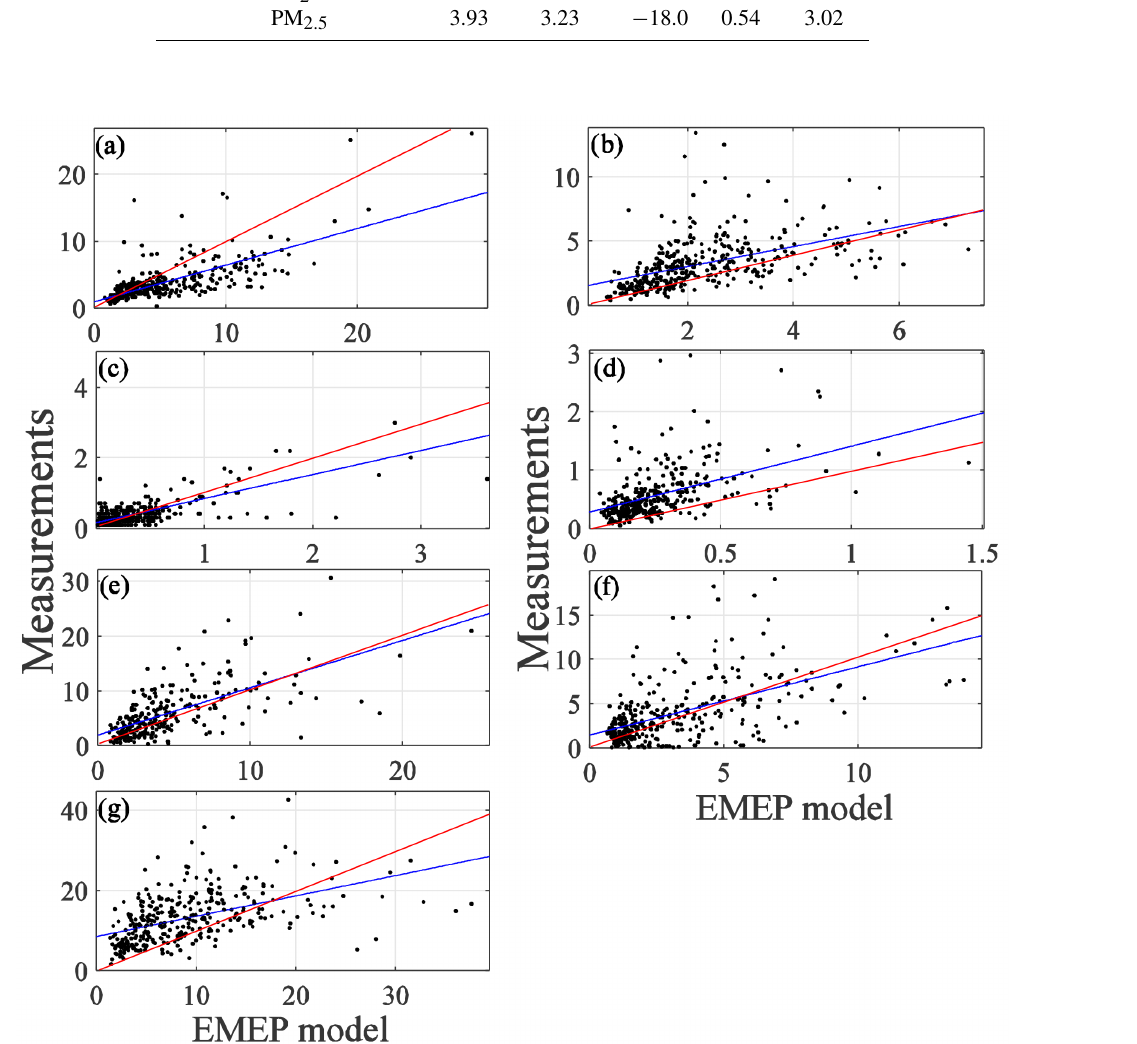
Figure A1. Scatter plots of model results vs. measured data of daily average concentrations of SO 2 , NO 2 , and particulate matter at Vav- ihill (a, c, e, g) and Utö (b, d, f) in the year 2013 (µgm − 3 ). The red line corresponds to a 1 : 1 ratio, and the blue line shows the linear relationship between measured and modelled